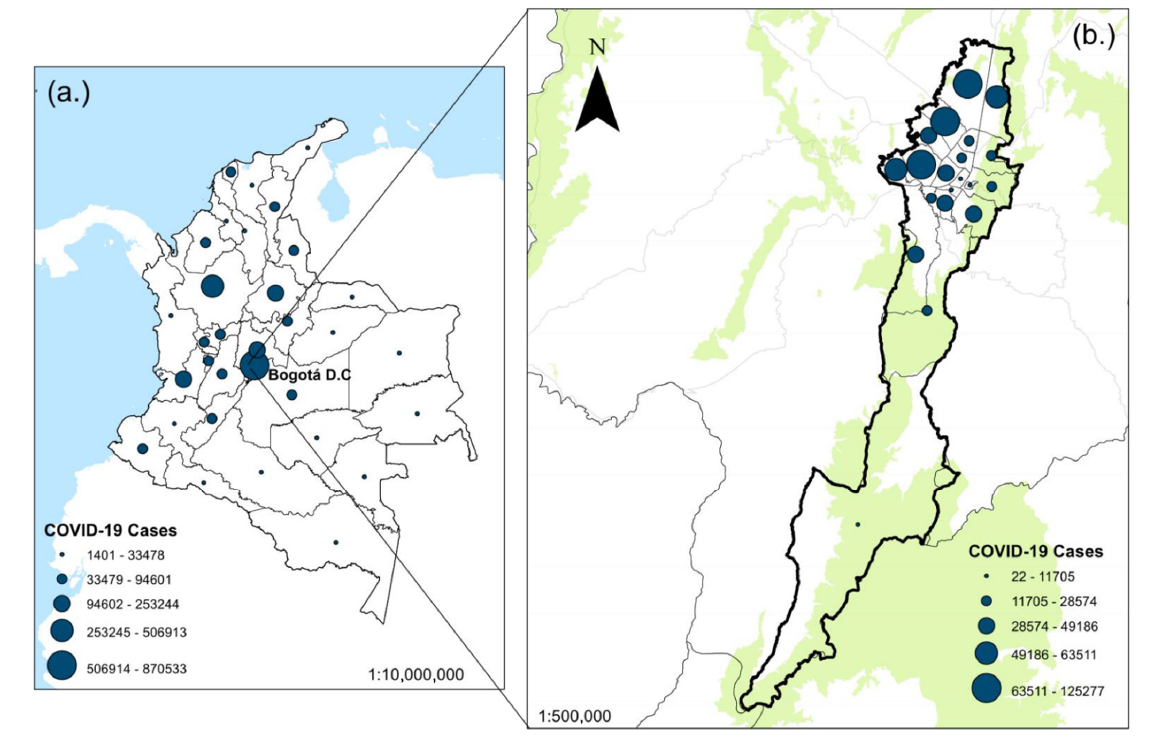
Figure 1. ( a ) SARS-CoV-2 cases in Colombia from 6 March 2020 until 18 May 2021; ( b ) study area, showing COVID-19 cases in Bogotá until 18 May 2021. The size of the circles is directly related to the number of infections since the first day of reporting. The geographical information system ArcGIS 10.5 for Desktop version 10.5.0.6491 was used to generate Figure 1. The Colombian administrative divisions and other geographic layers were downloaded from https://www.datos.gov.co/browse?sortBy=newest&utf8=%E2%9C%93 (accessed on 15 March 2022). COVID-19 data were obtained